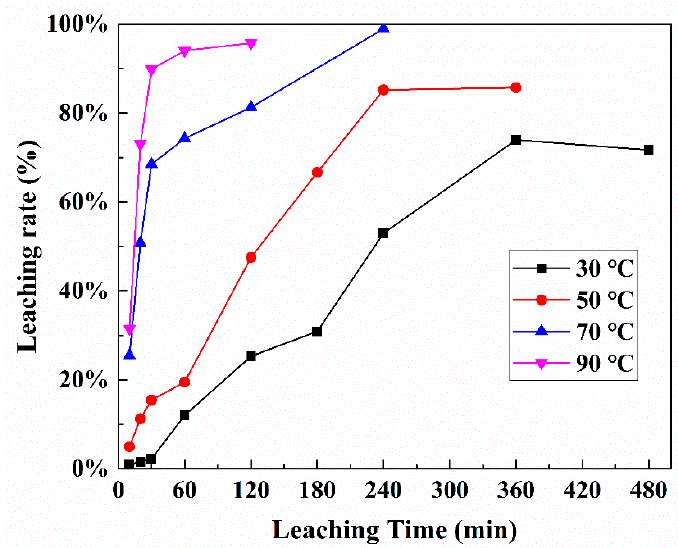
Figure 8. Leaching rate of Pt under different reaction temperatures and times.